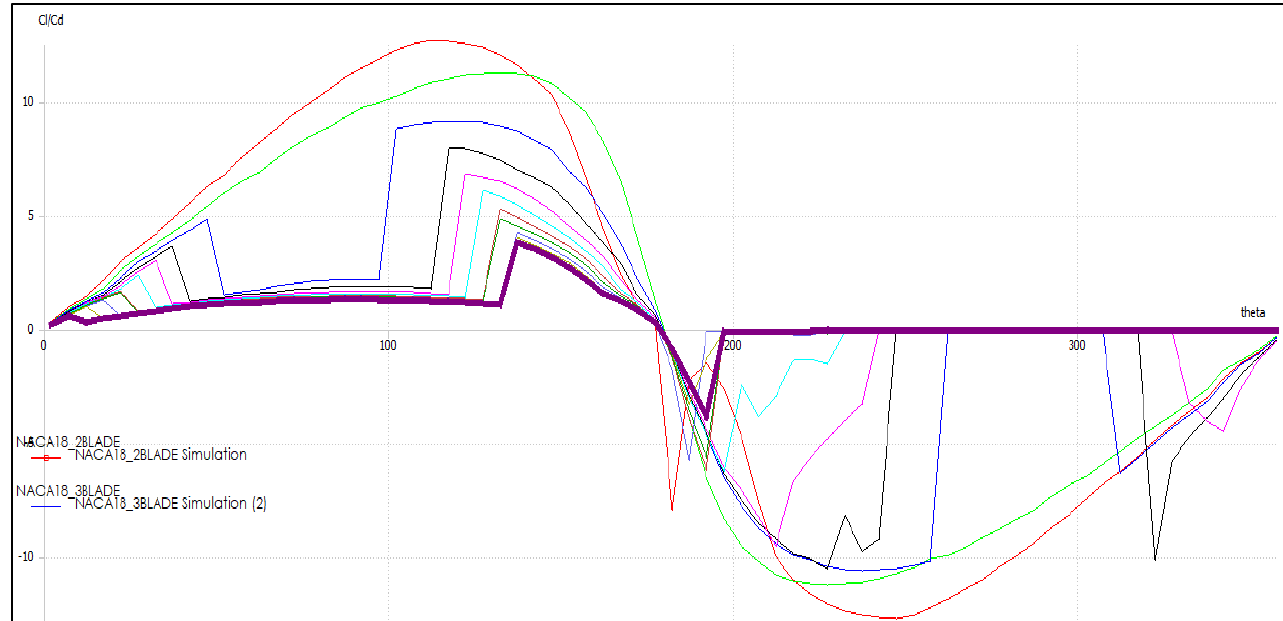
Figure 40 . Cl/Cd vs theta plot of bottom-section for TSR